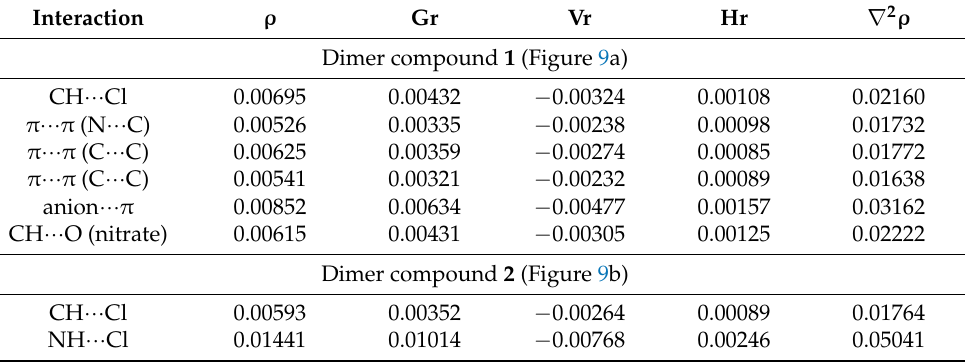
Figure 9. Combined QTAIM (bond CPs shown in red and bond paths shown as orange lines) and RDG isosurface analyses of the assemblies of compounds 1 ( a ) and 2 ( b ). Table 4. QTAIM parameters at the bond CPs depicted in Figure 9. The density ( ρ ), Lagrangian kinetic energy density (Gr), potential energy density (Vr), total energy density (Hr) and Laplacian ( ∇ 2 ρ ) are given in